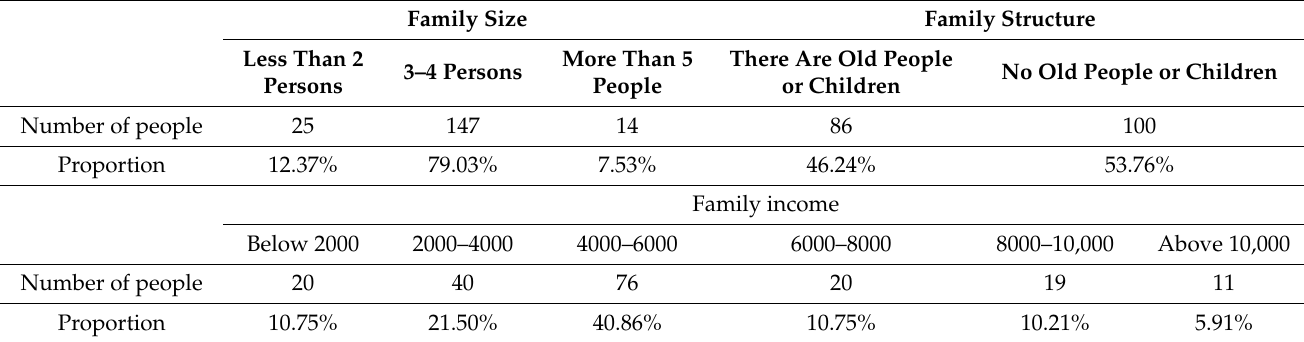
Table 3. Statistics of basic family information of respondents.